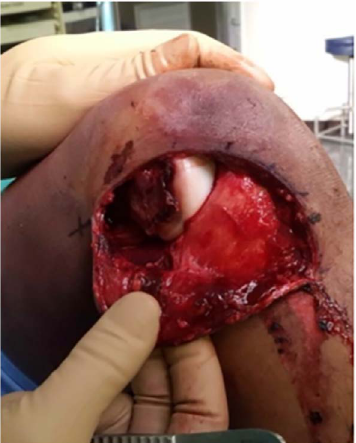
Figure 1. Large medial capsular tear with exposed medial condyle after skin incision in an irreducible knee dislocation. This allows access to the tibial insertion of the posterior cruciate ligament through the traumatic arthrotomy without extensive surgical